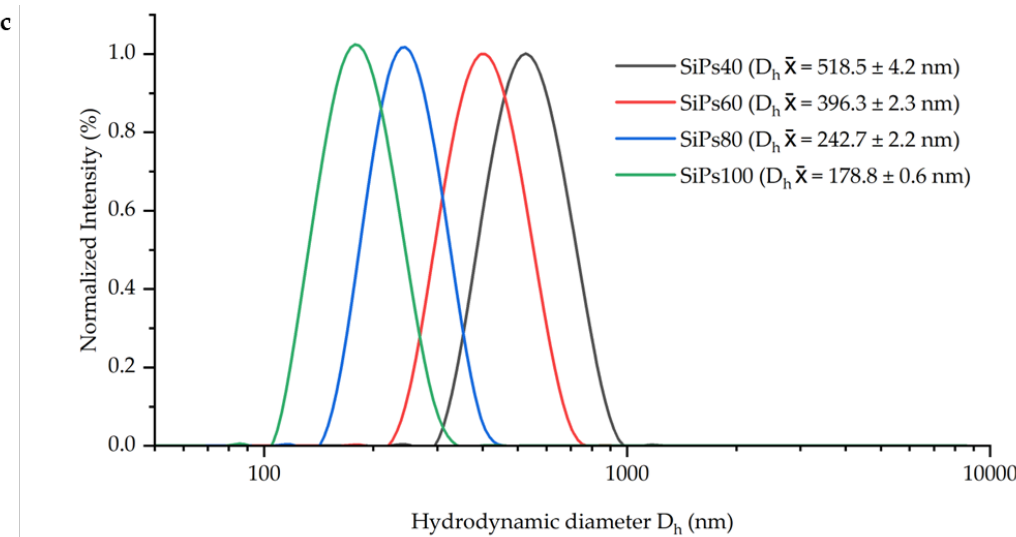
Figure 2. Synthesis and characterization of the SiPs. ( a ) Scheme of the SiPs synthesis. After the adhesion of TEOS to the ethanol solution, hydrolysis takes places promoting the formation of the silanol network. This in turn starts the nucleation for the formation of the SiPs. ( b ) SEM images of the obtained SiPs, and the representation of the inversely proportional relationship between the amount of EtOH and the final diameter of the SiPs. ( c ) Hydrodynamic sizes of the SiPs measured via DLS. The hydrodynamic diameter is usually a higher value than the diameter since it refers to moving particles in a solution.